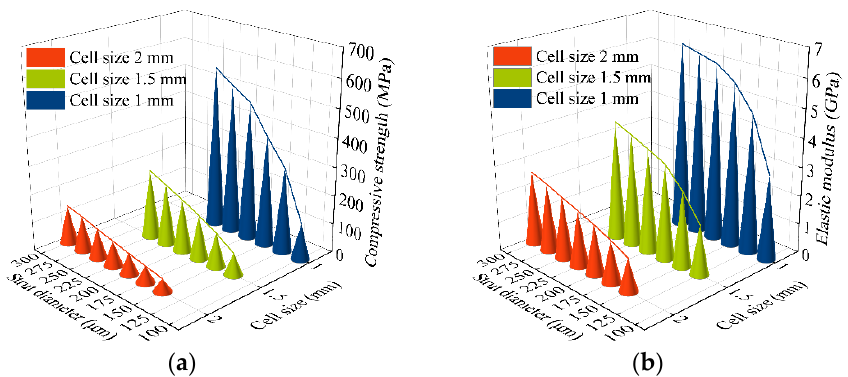
Figure 9. Mechanical properties of porous Ti6Al4V alloy: ( a ) compressive strength; ( b ) elastic modulus.